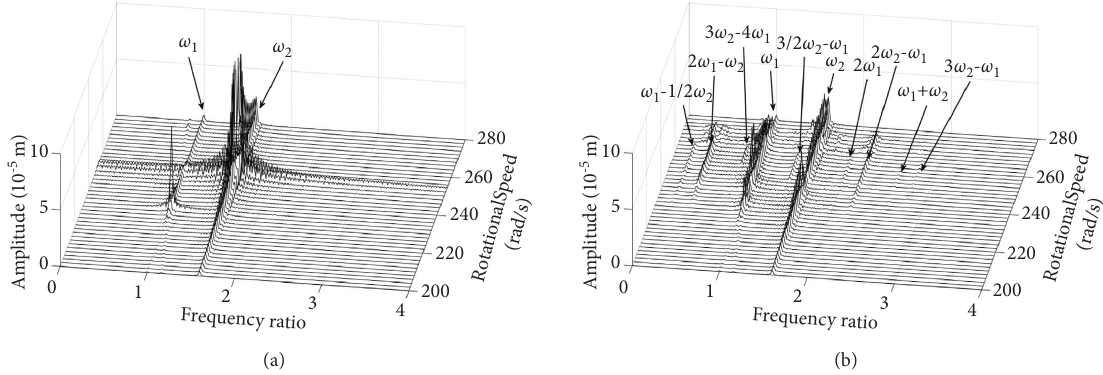
Figure 12: Waterfall spectrum plots for the lateral vibration of disk 4 during level flight. (a) Without rub-impact. (b) Rub-impact.